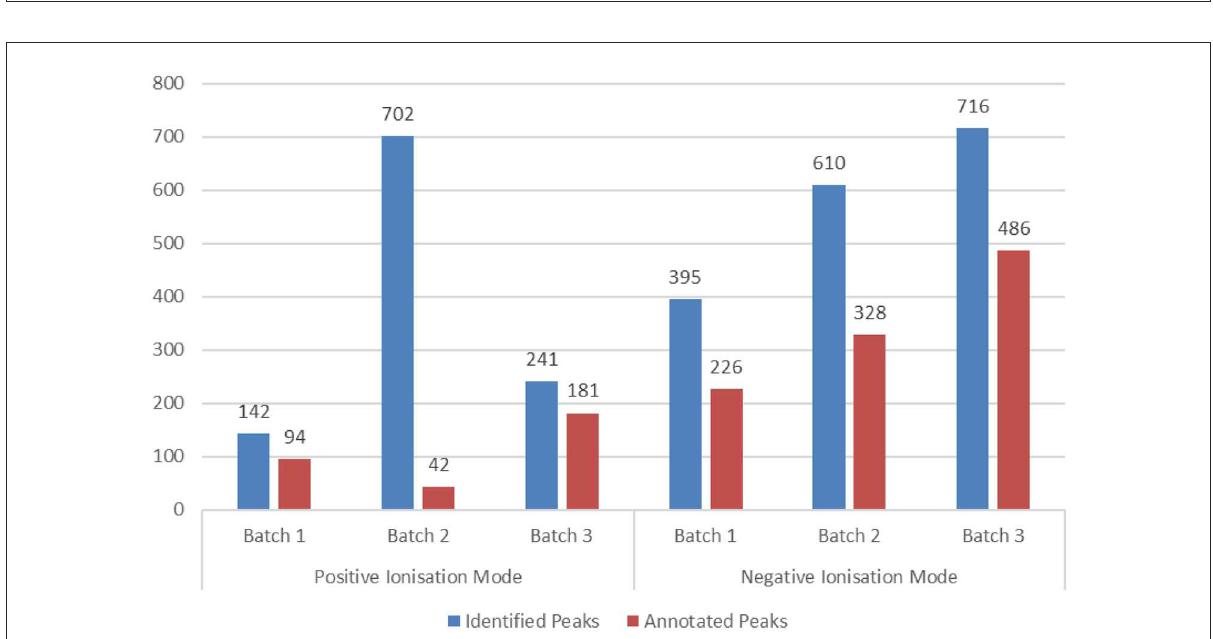
FIGURE9 Metabolomics analysis results per analyzed batch and ionization mode of the HERACLES cohort. The samples were analyzed in three different analytical batches due to technical limitations of the used platform. At the end of each batch, the system was cleaned and re-calibrated to avoid the introduction of variations. In total, 2,806 peaks were identified, while 1,742 were annotated and used as input for the pathway